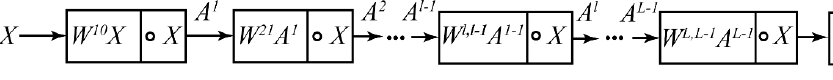
Figure 8. Graphical illustration of learning rules.